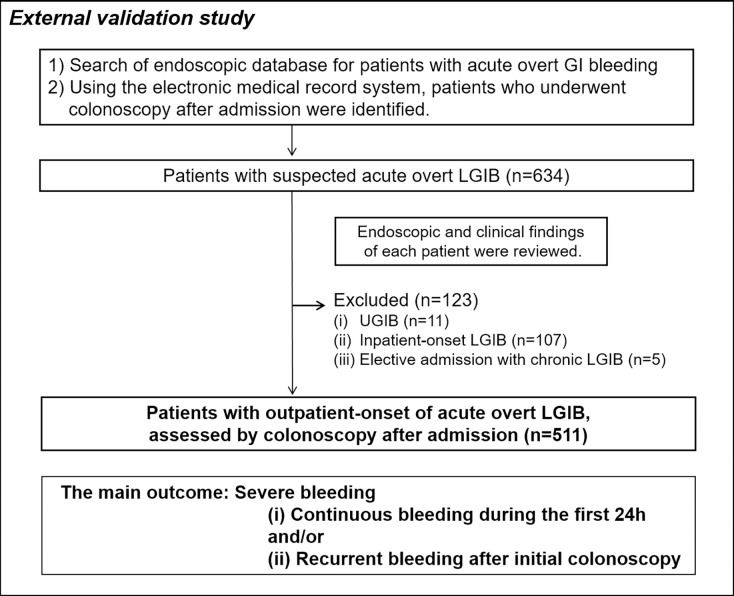
Flow chart of patient selection.LGIB, lower gastrointestinal bleeding; UGIB, upper gastrointestinal bleeding.